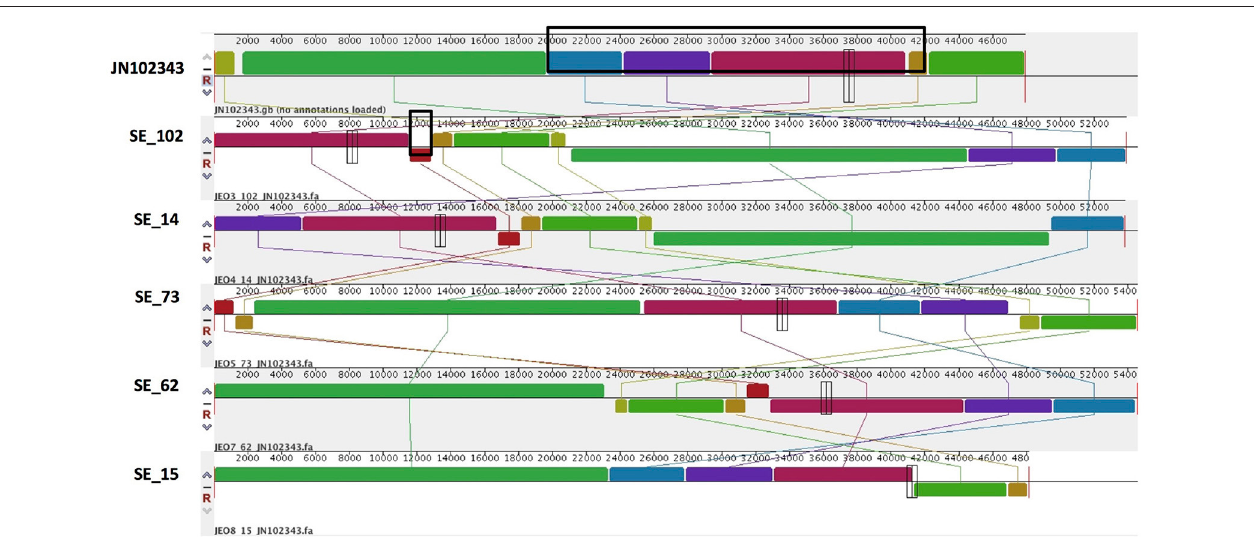
FIGURE 3 | Alignment of IncN plasmid homologs of Salmonella Enteritidis to a reference plasmid JN102343. The alignment was created with MAUVE. The top row shows the reference plasmid, and the rows below the reconstructed plasmids in Salmonella Enteritidis from the study. Each of the colored blocks outlines a region of the genome sequence that aligned to part of another genome, and is presumably homologous. Areas with no blocks were not aligned and contain sequence elements specific to a particular genome. The black box in the reference plasmid surrounds a block found to contain antibiotic resistance genes strA, strB, tet(A), blaTEM-1B found in all isolates. The box in SE_102 indicate an insertion of sul1, dfrA15 , which was found to be absent reference plasmid and in SE_15 isolate.